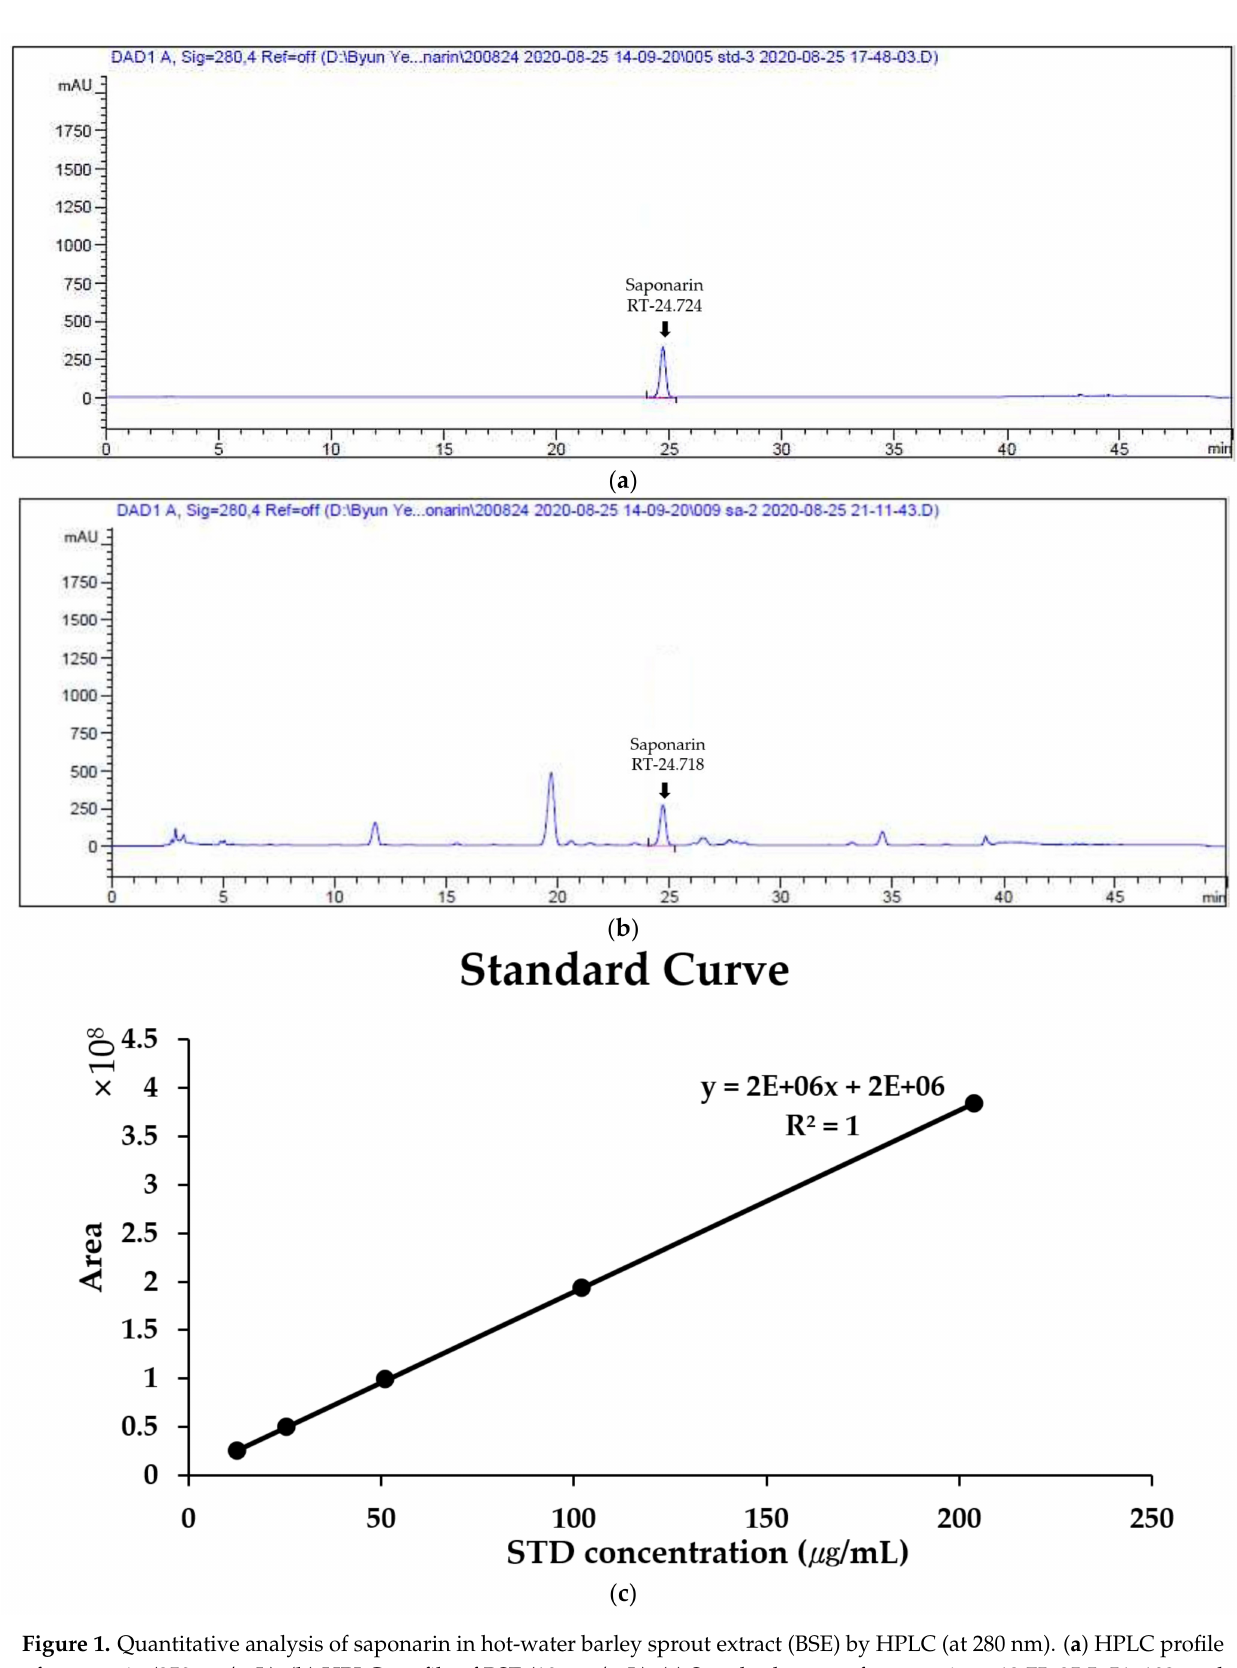
Figure 1. Quantitative analysis of saponarin in hot-water barley sprout extract (BSE) by HPLC (at 280 nm). ( a ) HPLC profile of saponarin (250 µ g/mL). ( b ) HPLC profile of BSE (10 mg/mL). ( c ) Standard curve of saponarin at 12.75, 25.5, 51, 102, and 204 µ